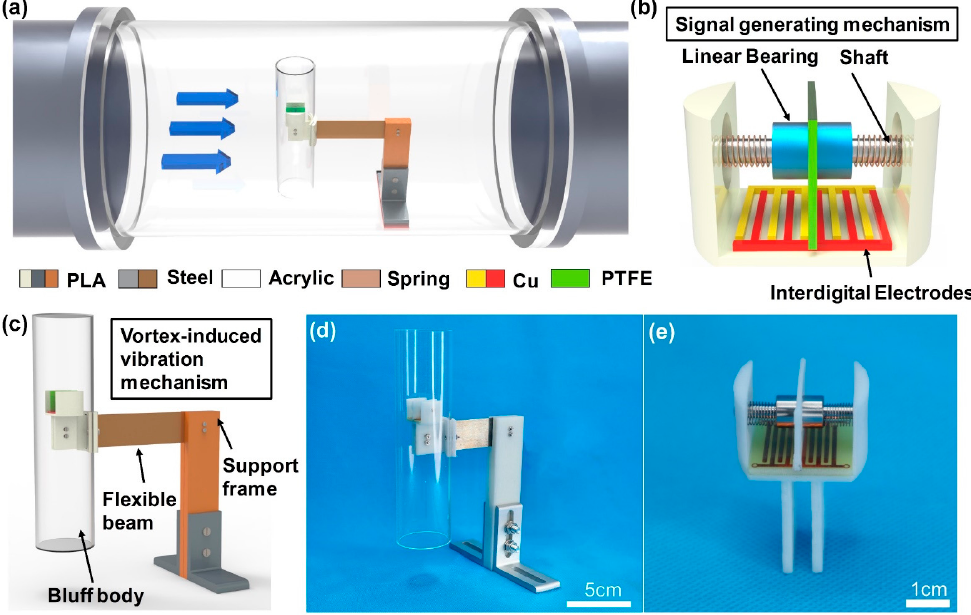
Figure 1. Schematic diagrams of the AVM: ( a ) the AVM in pipeline; ( b ) the structure of the signal generating mechanism; ( c ) schematic diagram of AVM; ( d , e ) prototypes of the AVM.